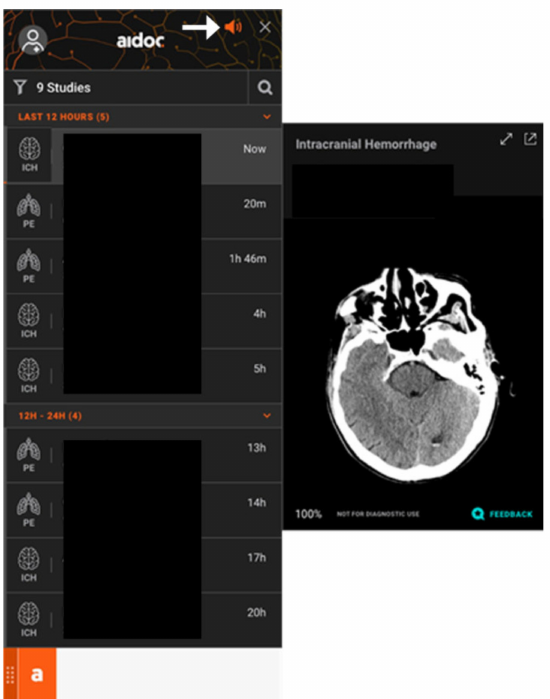
Figure 1. Example of the Aidoc widget on the workstation that alerts the radiologist when new flagged cases appear on the PACS worklist. The widget lists studies that are positive for acute intracranial hemorrhage and selected images with findings can be viewed for each patient. The widget includes an audible alert feature (arrow). The patient names on this image are hidden for